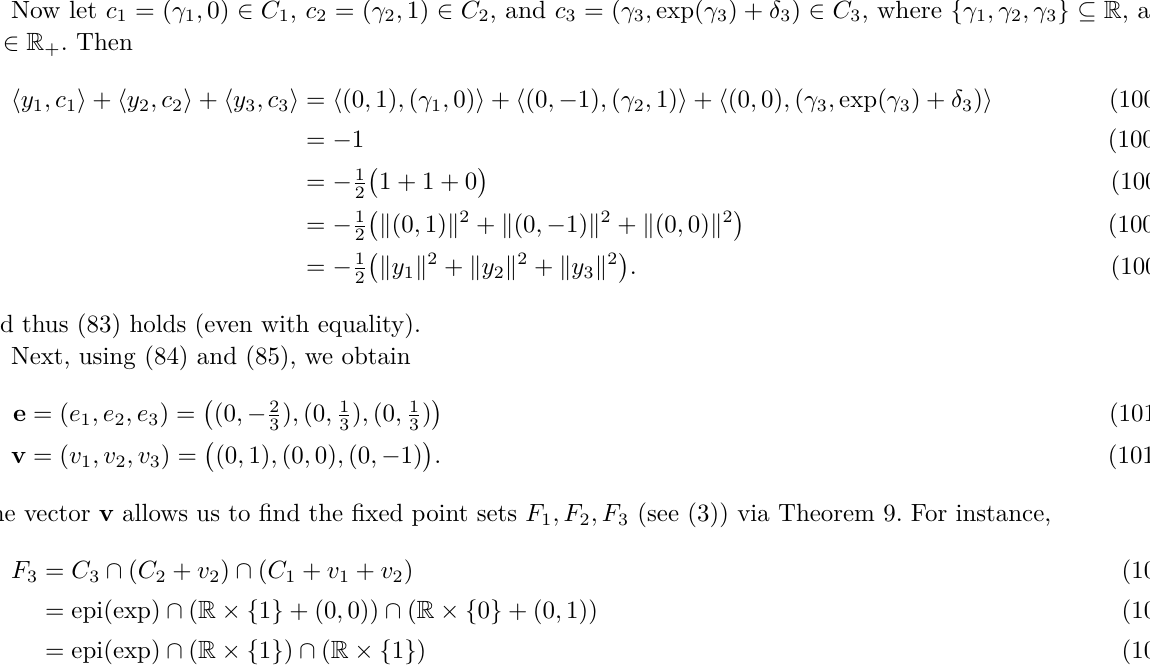
Figure 2 Visualization of the cycle and the difference vectors for three lines in R 3 that are not parallel. See Section 5.1.2 for